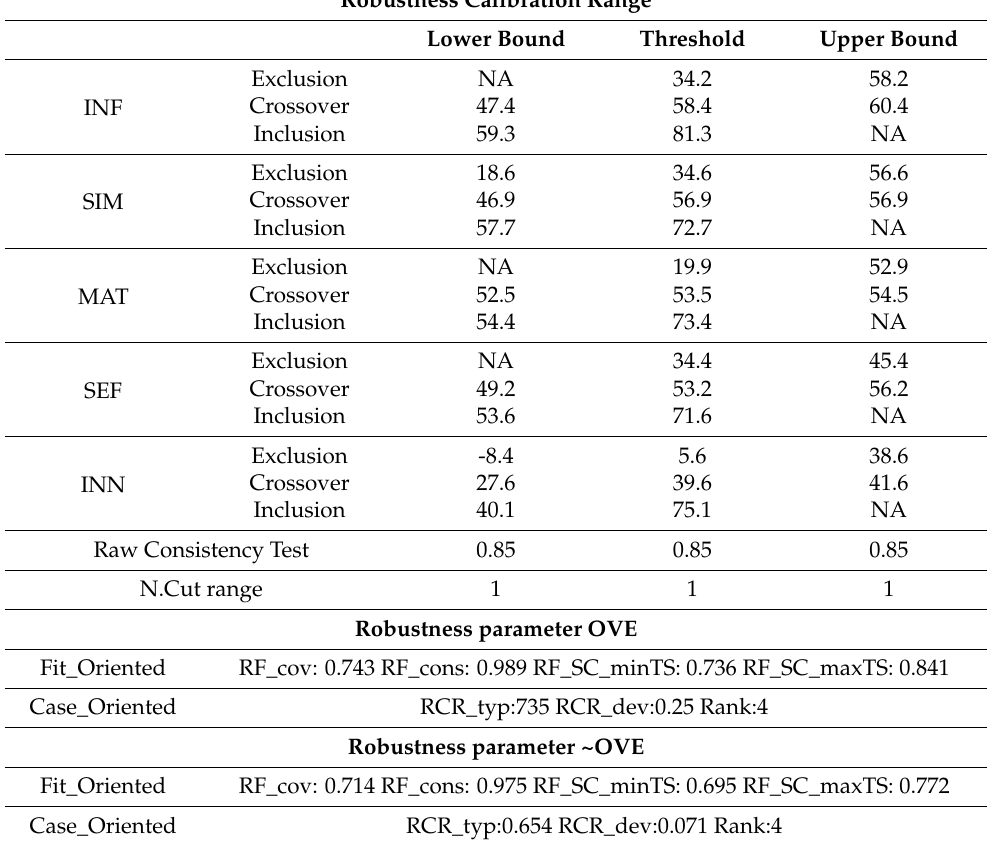
Table 5. Robustness